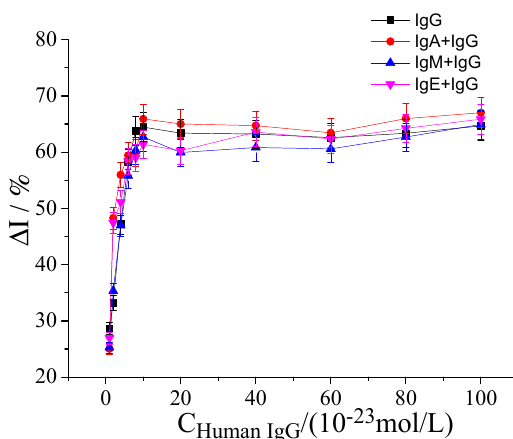
Figure 10. The change rate of response current of hFc γ Rn electrochemical receptor sensor to IgG, IgA + IgG, IgM + IgG, and IgE + IgG. The concentration range of IgA in IgG solution was 10 − 23 to 10 − 20 mol / L, and the concentrations of IgA, IgM, and IgE in the same volume were 10 − 6 mol / L.